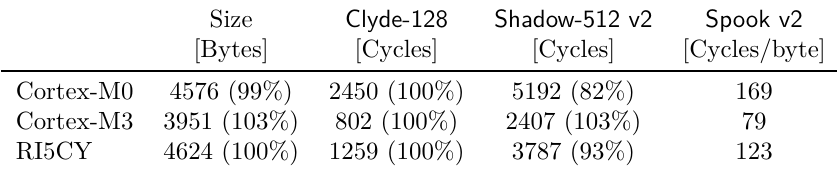
Table 17: Speed-optimized performances on embedded platforms (-O3). The percentages are the comparison with the Spook v1 corresponding metrics.